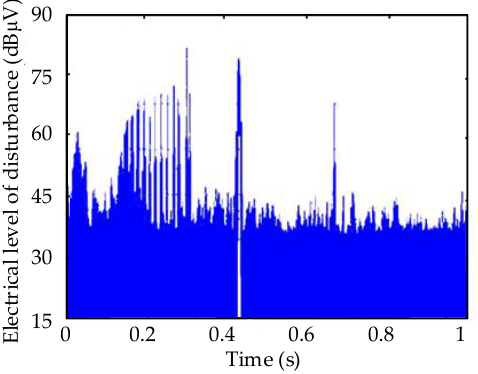
Figure 7. Disturbance received by the antenna when the train is in a normal operational situation.